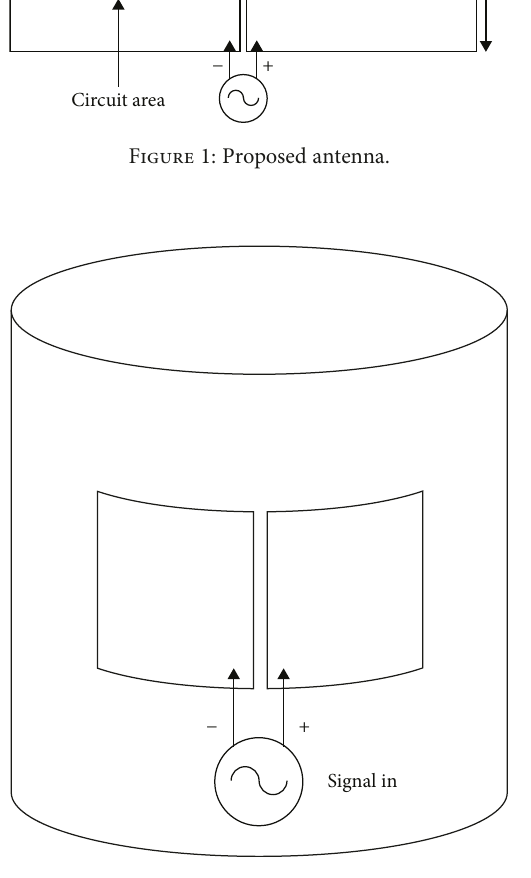
Figure 2: Foldable characteristic in operation.